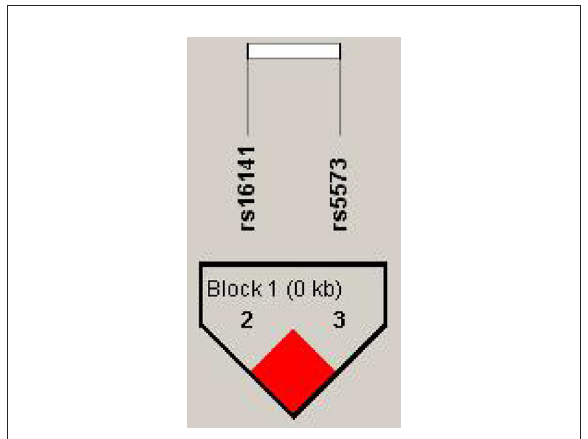
FIGURE1 Linkage disequilibrium block structure across NPY gene. The figure show the output of Haploview (version 4.0) LD Plot where each square (with D , values written within the box) represents a pair-wise LD relationship between the two SNPs. Red squares indicate statistically significant LD between the pair of SNPs as measured by the D ,